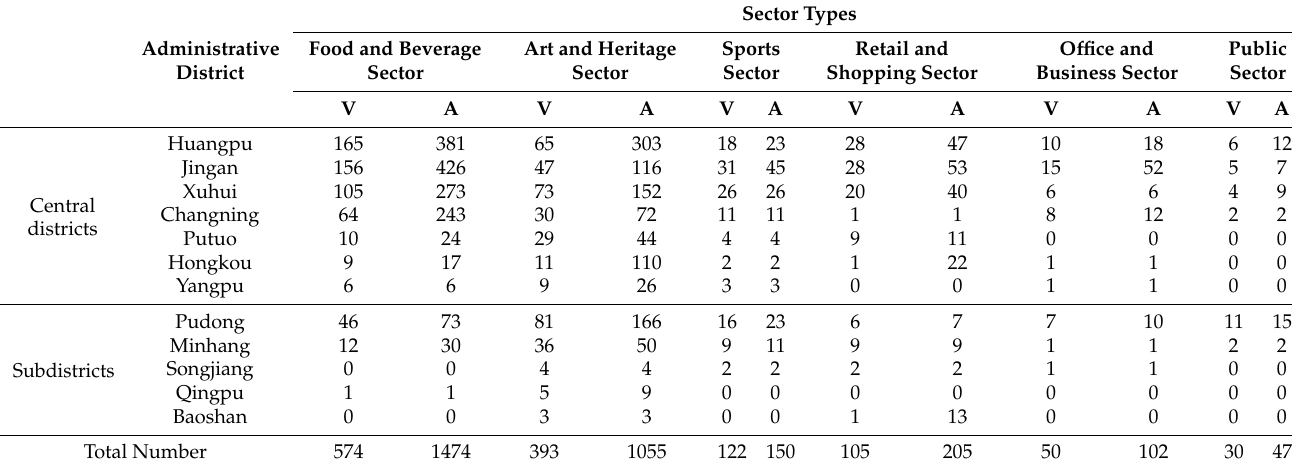
Table 3. Number of venues and activities held in venues in six sectors.